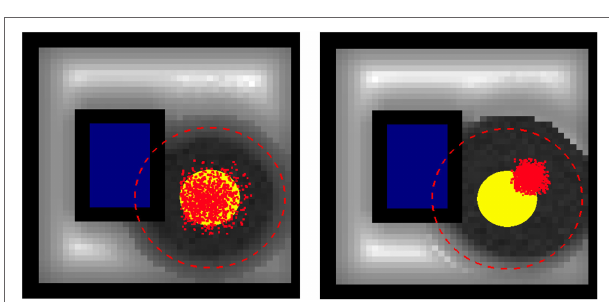
FiGUre 4 | Robot empowerment (in grayscale: dark—low, bright—high) dependent on the robot position. Obstacles in blue. Two different human (yellow circle) behavior models are considered. If the robot would be within the safety shutdown distance (red circle), it is not able to act. The red dots are the endpoints of the 2,000 random human action trajectories used for possible action predictions, the two graphs differ in the assumed distribution of human movement in the next three steps. If one compares the empowerment close to the safety shutdown distance, one can see that the assumed human behavior influences the estimated empowerment while all other aspects of the simulation remain unchanged.